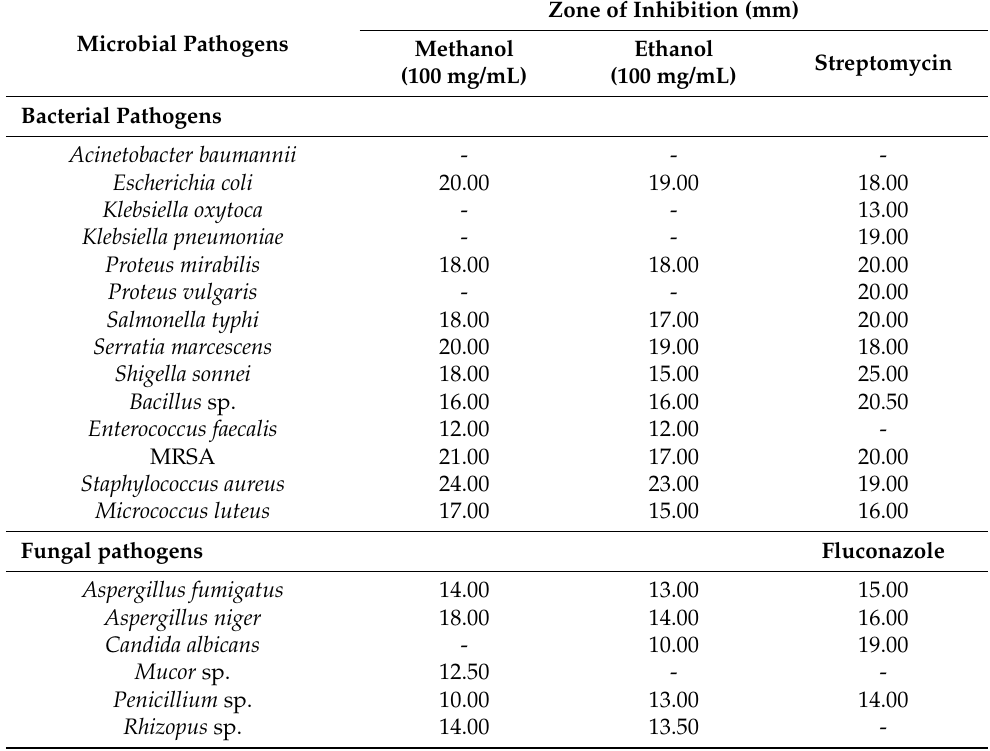
Table 2. Antimicrobial activity of plant extracts.